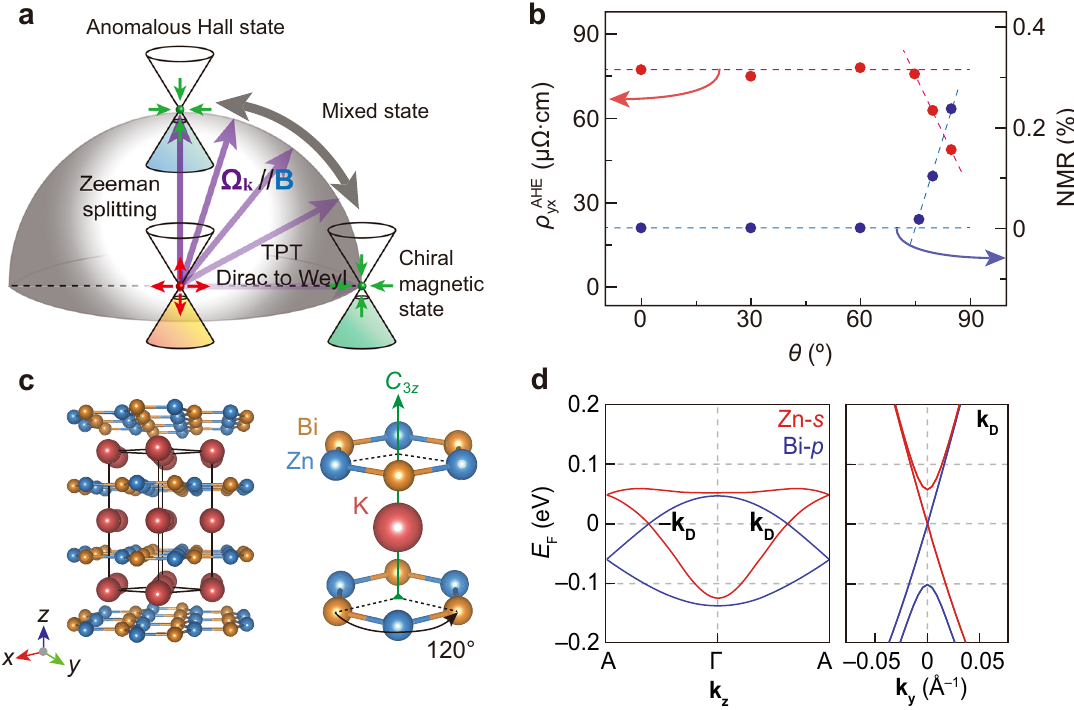
Fig. 1 Tunable Berry curvature and quantum transport phenomena in 3D TDS KZnBi. a B-dependent Weyl cone splitting and net Ω k , which determines quantum transport phenomena of the 3D TDS. The source (red arrows) and sink (green arrows) of the Ω k are located at two Weyl points. The net Ω k (purple arrows) is tunable by varying the angle ( θ ) of external B. TPT is an abbreviation of topological phase transition. b θ - dependent anomalous Hall resistivity ( ρ AHE , red dots) at saturation and negative magnetoresistance (NMR, blue dots). Dashed lines are guides yx to the eyes. c Crystal structure of the KZnBi constructed by planar ZnBi honeycomb and K ion layers (left panel), which has C 3 z rotational and inversion symmetries (right panel). d Band structure of the KZnBi that contains two Dirac cones at ±k D (left panel) which is constructed by Zn- s (red lines) and Bi- p (blue lines) orbitals (right